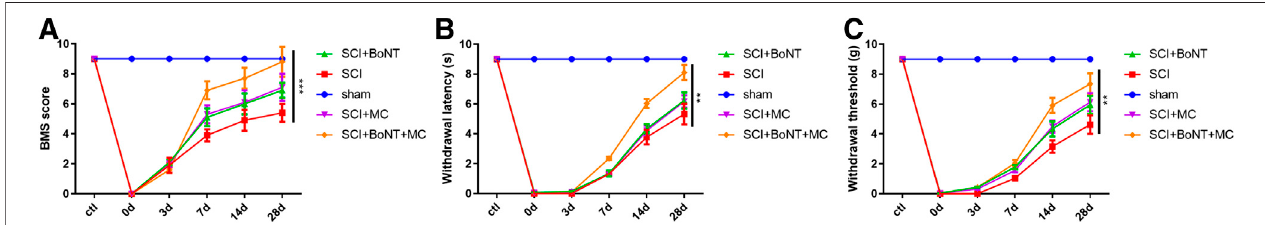
Frontiers in Pharmacology |